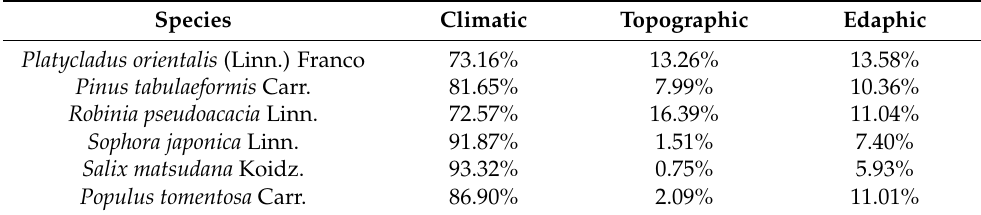
Table 7. Importance of environmental factor groups for each species. Species Climatic Topographic Edaphic Platycladus orientalis (Linn.) Franco 73.16% 13.26% 13.58% Pinus tabulaeformis Carr. 81.65% 7.99% 10.36% Robinia pseudoacacia Linn. 72.57% 16.39% 11.04% Sophora japonica Linn. 91.87% 1.51% 7.40% Salix matsudana Koidz. 93.32% 0.75% 5.93% Populus tomentosa Carr. 86.90% 2.09%